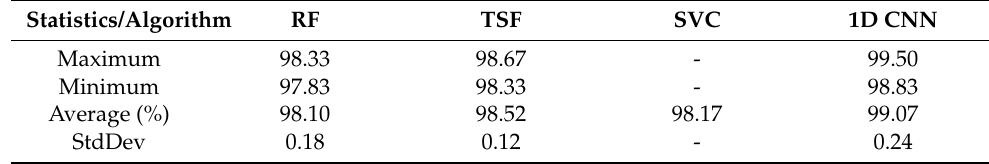
Table 5. Performance statistics of experiment